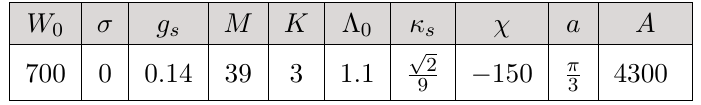
Table 2. Choice of parameters for the potential (4.11), with β (cid:29) 1 .